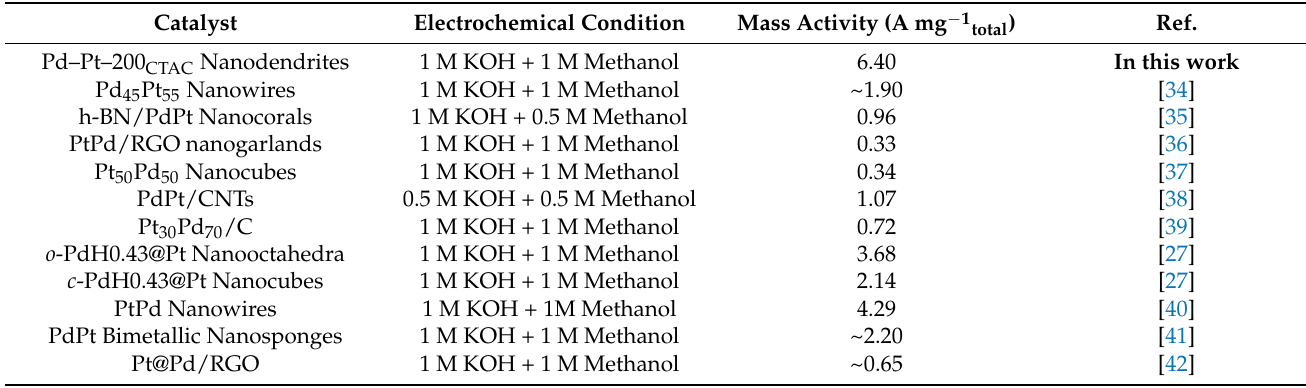
Table 2. Comparative results for electrochemical MOR activity based on previous reports using Pd–Pt-based catalysts in the